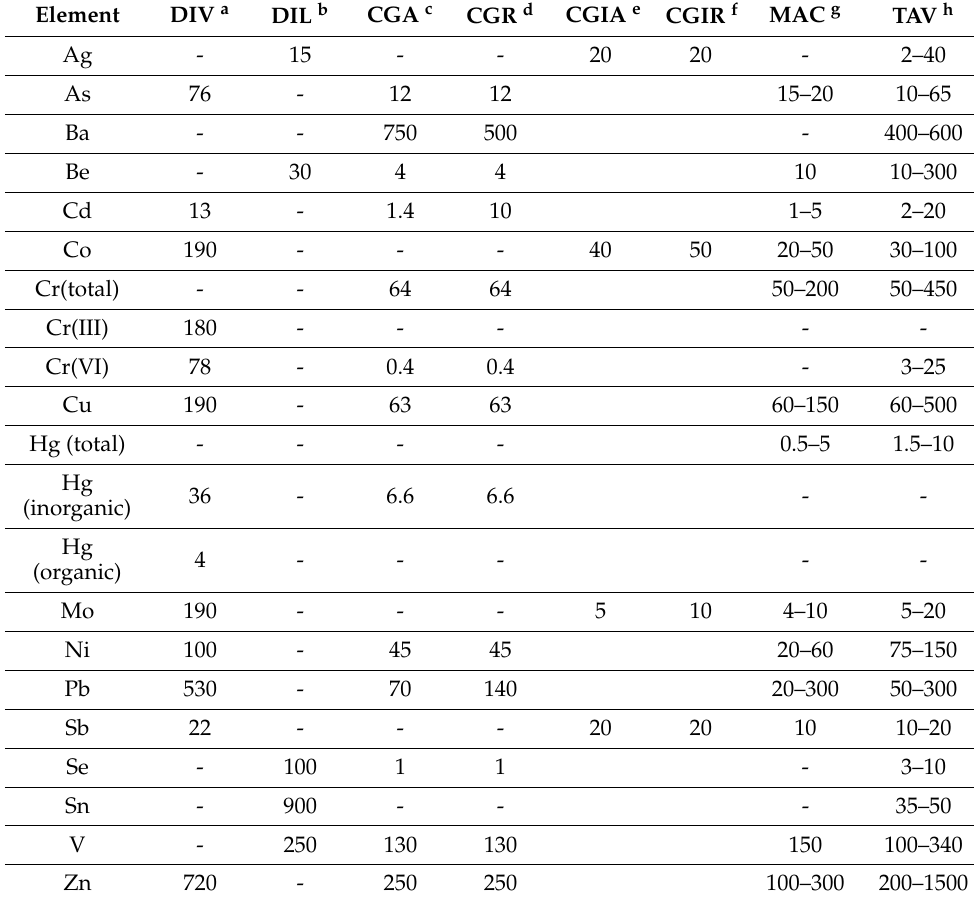
Table 4. Dutch and Canadian guidelines and values published by Kabata-Pendias et al. [61] for threshold concentrations of trace elements in agricultural soils (mg/kg). Data from